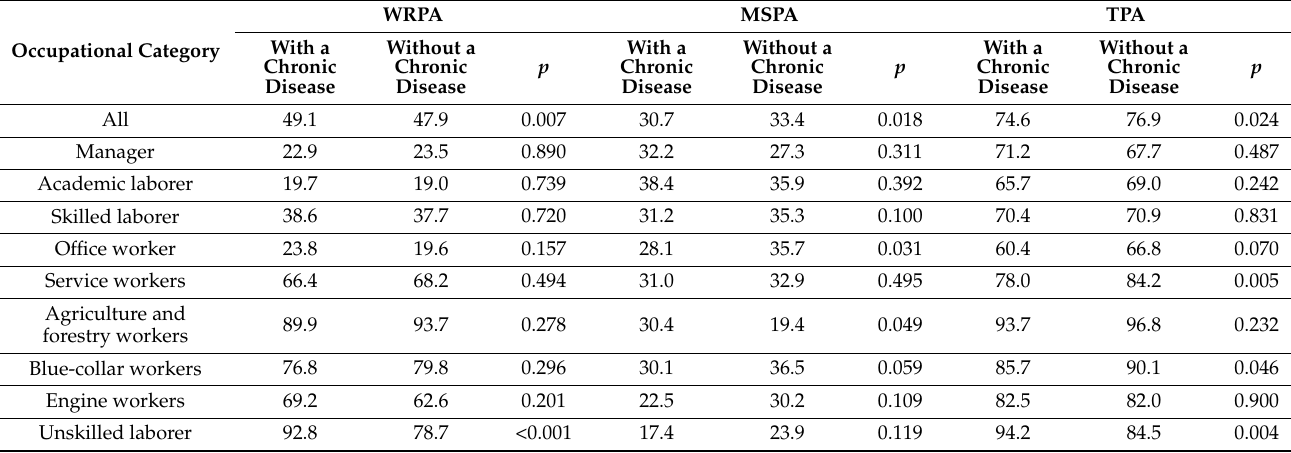
Table 5. Proportion of people who reached the respective thresholds in the different domains of physical activity in gainfully employed persons in Austria, stratified by the presence or absence of any chronic disease.